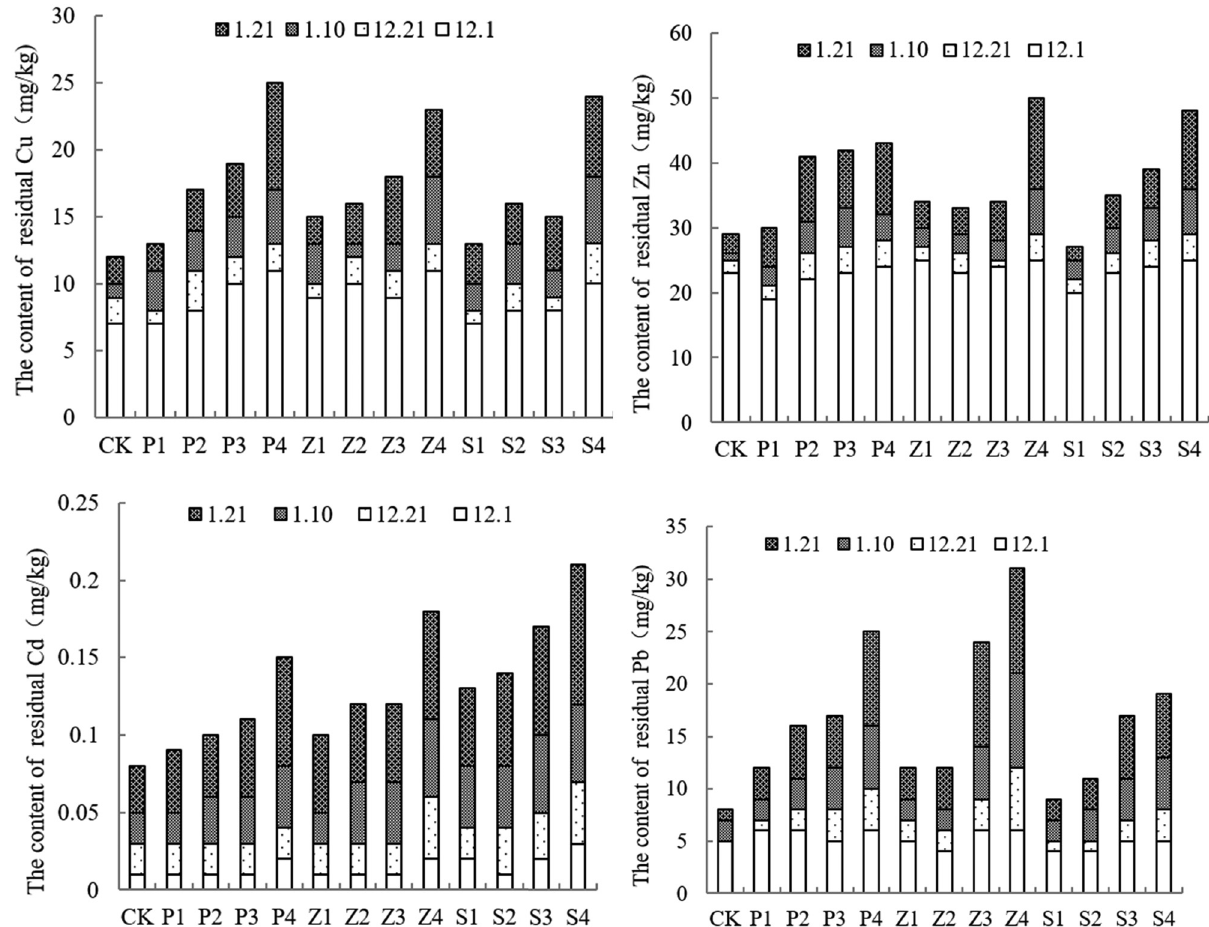
Figure 3: Changesinthecontentofheavymetalresidues inthesoilat di ff erent cultivationtimes.Note:Thebarchartin the fi gureusesDecember 1, 2020 as the base, showing the increase in the content of heavy metals in residues in the soil with di ff erent treatments over